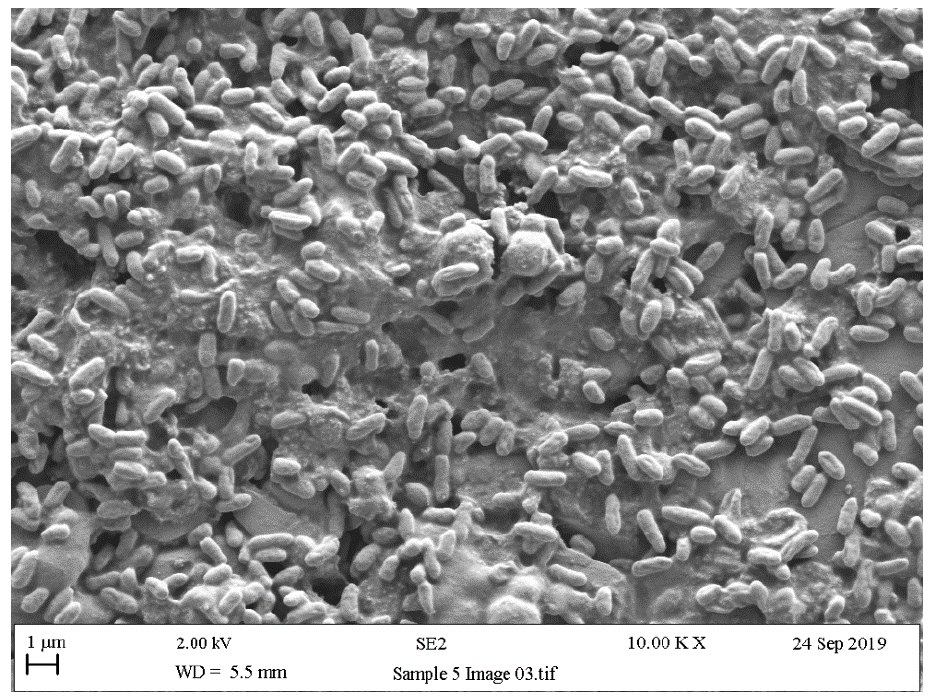
Figure 10. Scanning electronic microscopy (SEM) images of stainless steel of 7-day biofilms formed by Pseudomonas fluorescens.